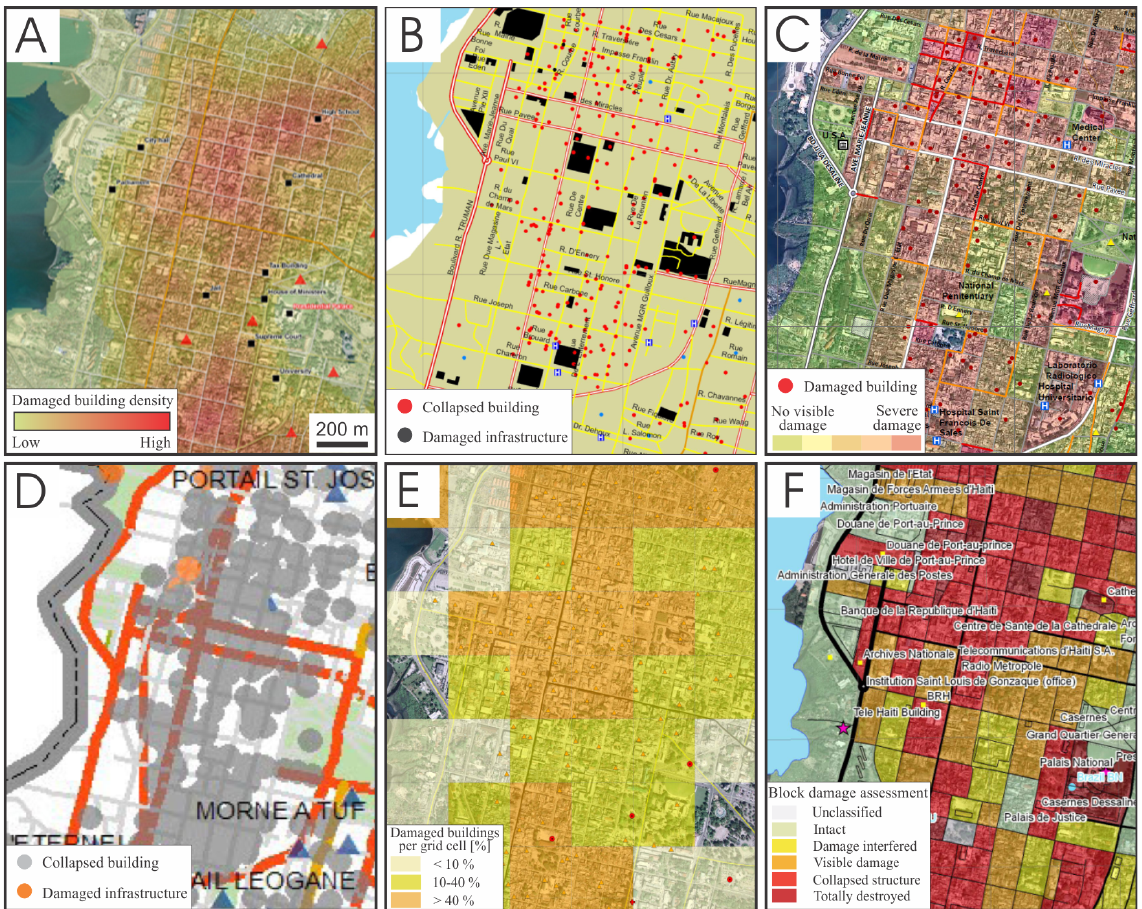
Fig. 1. Example damage maps of parts of Port-au-Prince (Haiti) following the 2010 earthquake, prepared by Service R´egional de Traitement d’Image et de T´el´ed´etection (SERTIT; A ), Information Technology for Humanitarian Assistance, Cooperation and Action (ITHACA; B ), United Nations Cartographic Section (UNCS; C ), Information Management & Mine Action Programs (iMMAP; D ), Crisis Information Center of the German Aerospace Center (DLR-ZKI; E ) and the alliance of the Italian Space Agency and Telespazio e-GEOS (F) . Legends adapted from original sources to show only elements related to structural damage. Note that map scales vary